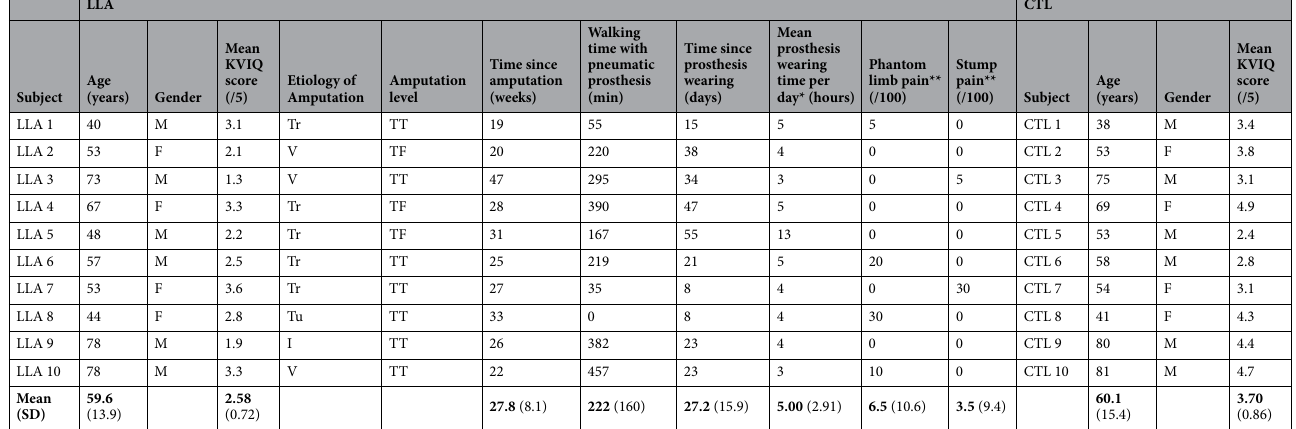
Table 1 summarizes the characteristics of the participants in the LLA and CTL groups.